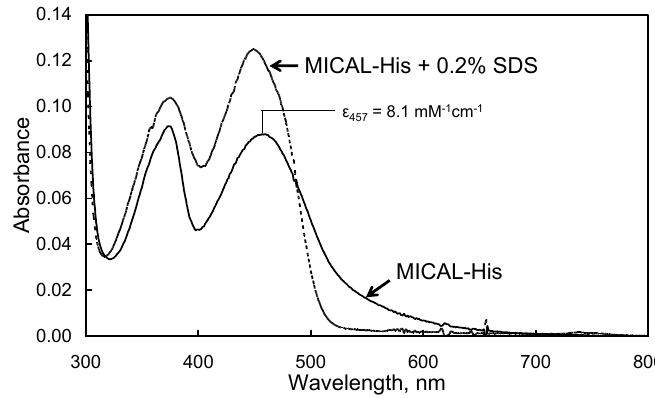
Figure 10. Comparison of the absorption spectra of human MICAL-MO and of the FAD cofactor released after protein denaturation. Reprinted from [70] with permission from